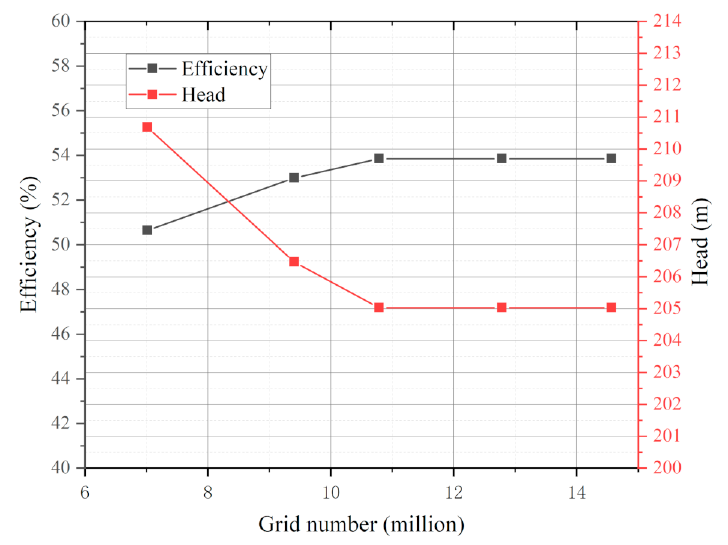
Figure 3. Effect of the number of grids on efficiency and